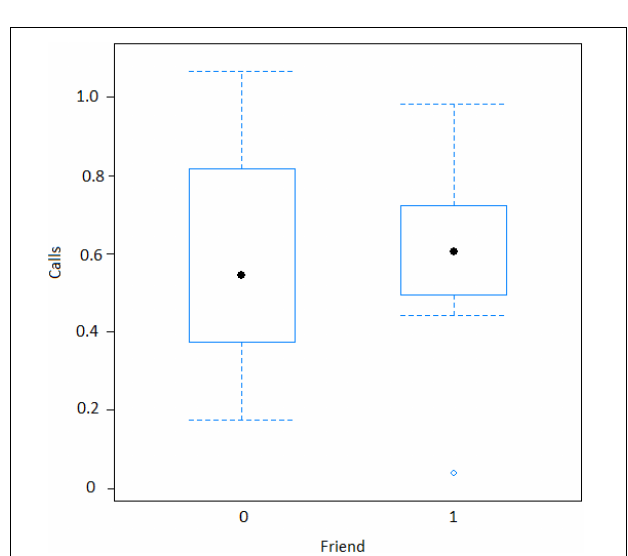
while visually locating the snake is only needed if the subject